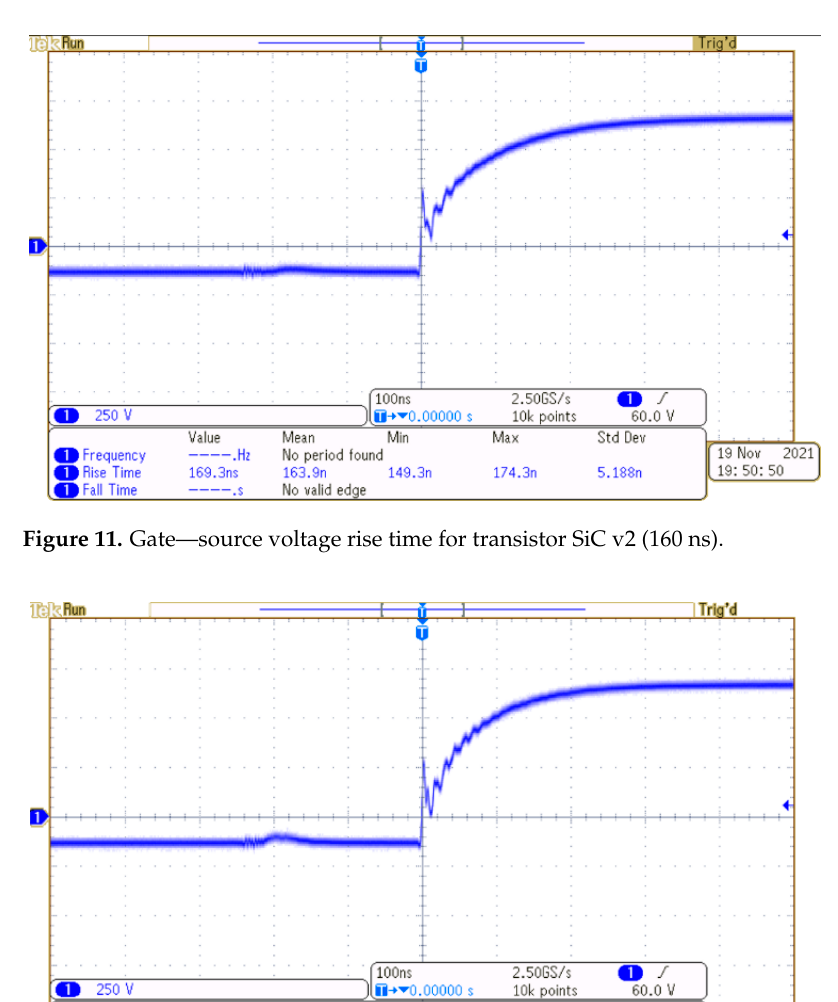
Figure 13. Gate—source voltage rise time for transistor SiC v4 (55 ns). Figure 14. Summary of the gate-source voltage rise-time for selected SiC transistors (evaluated pa- rameter—V grise [ns]).